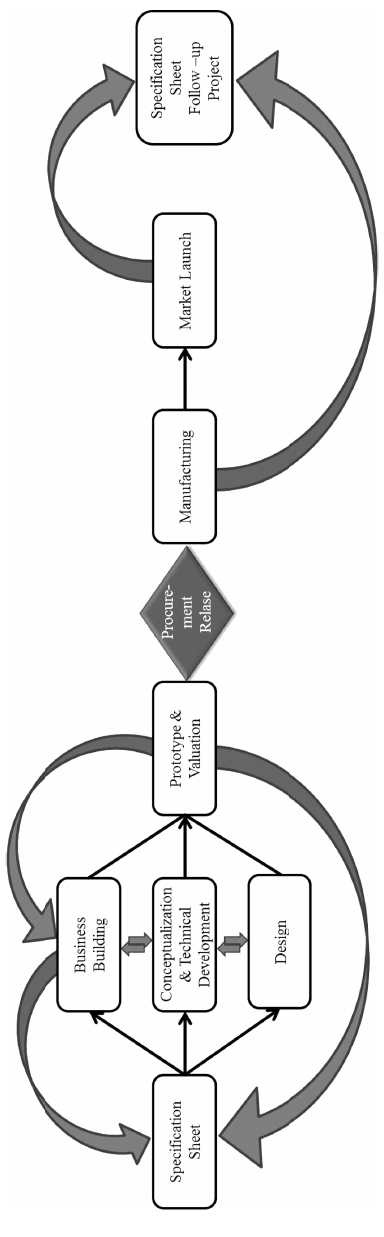
Figure 7. Bidirectional